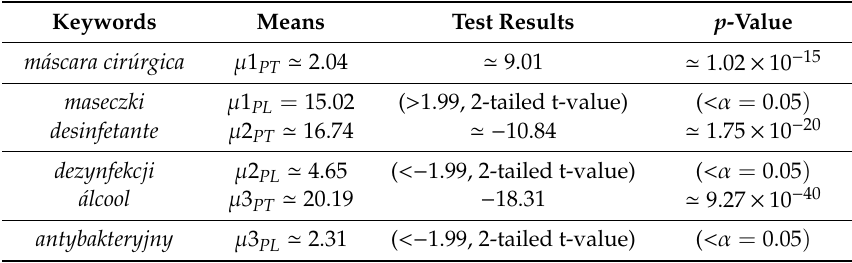
Table 2. Summary of the t-student test for two paired samples for means.